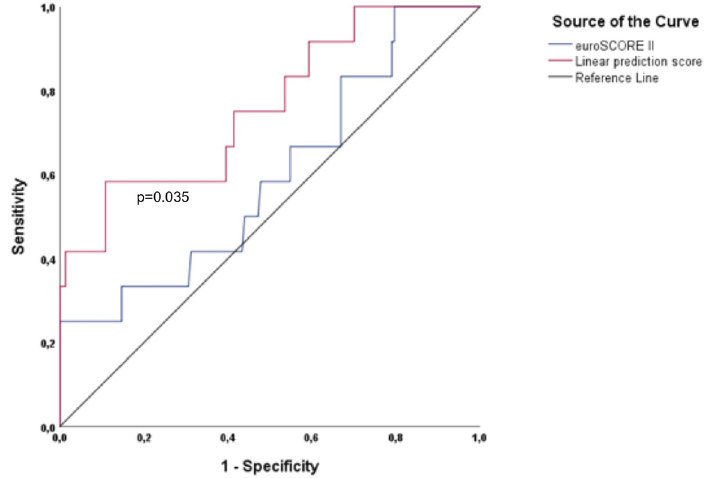
Figure 1. Shown is the area under the ROC curve for ESII and for the calculated linear prediction score 1 for the primary endpoint midterm mortality. The calculated linear prediction score (LPS) 1 (top) has a significantly higher ( p = 0.035) area under the ROC curve compared with ESII